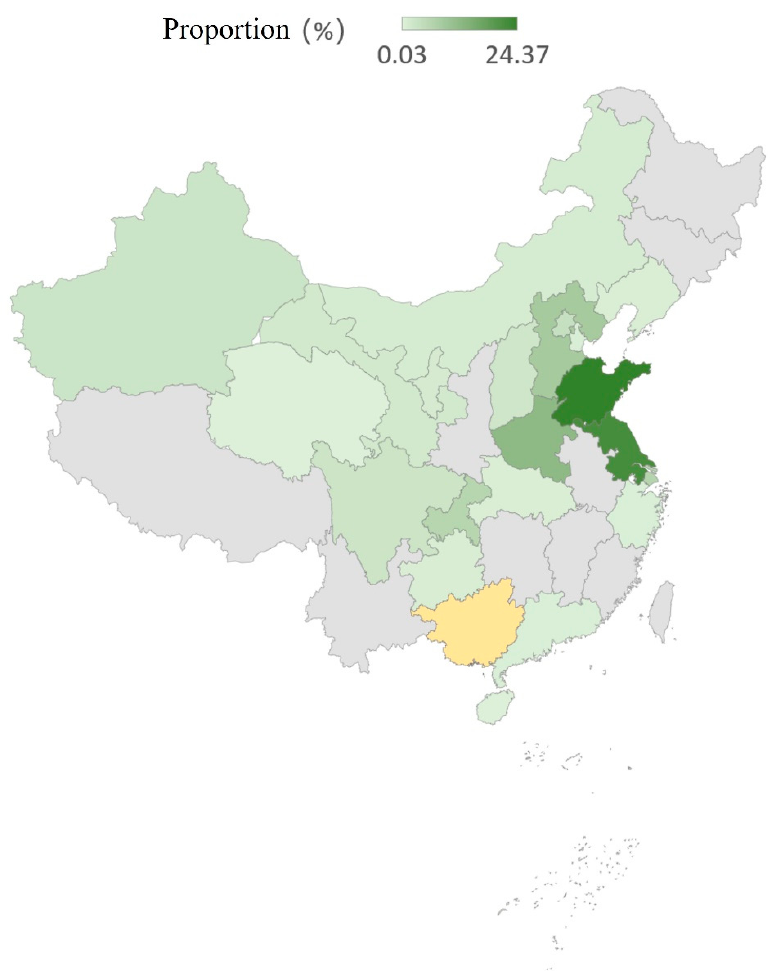
Figure 5. Analysis on the market spatial distribution of DK company in China.